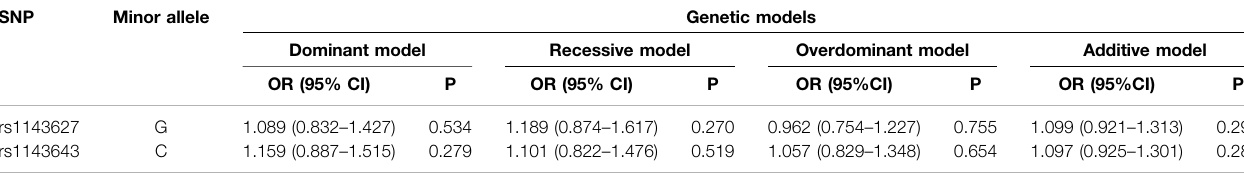
TABLE 4 | Genetic models of rs1143627 and rs1143643 between the T1DM group and control group [OR (95% CI)].